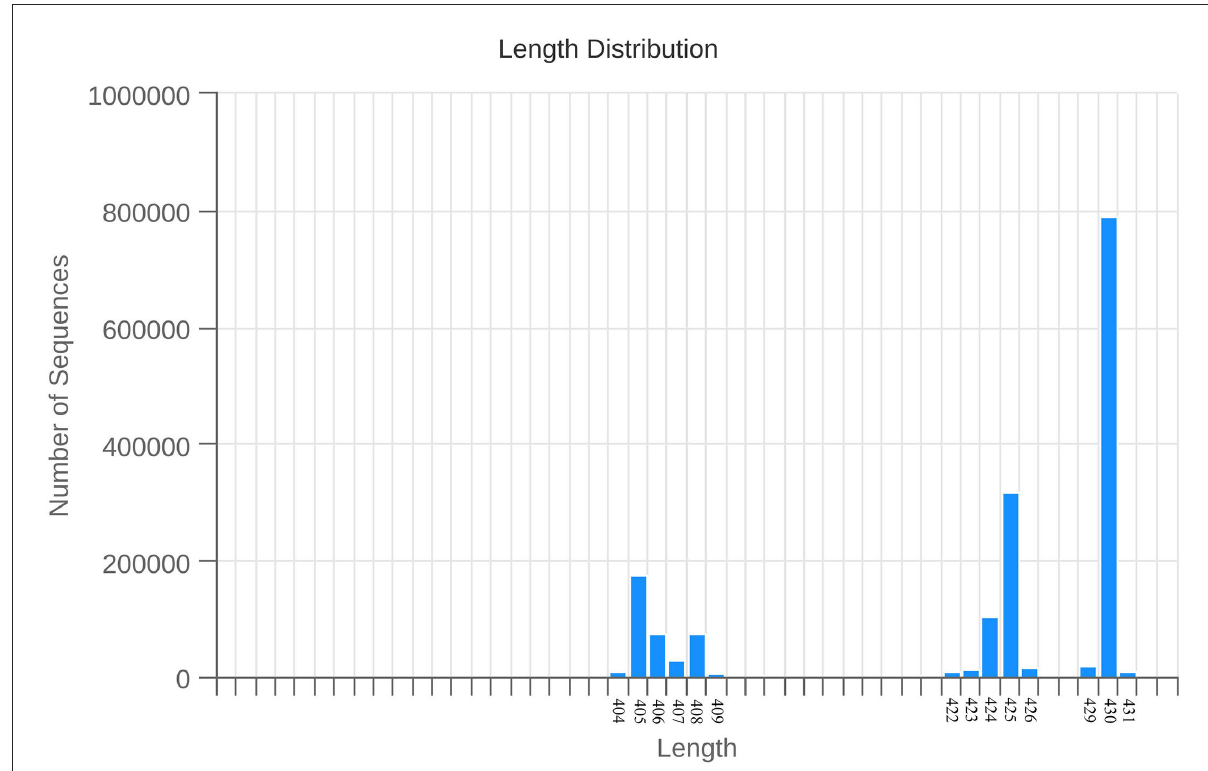
FIGURE5 Overall sample sequence length distribution. Note: The abscissa is the length of the sequence, and the ordinate is the number of sequences.